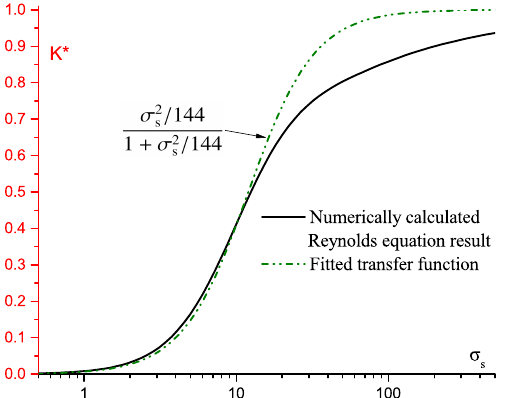
Figure 19. Fitted transfer function of dimensionless stiffness.